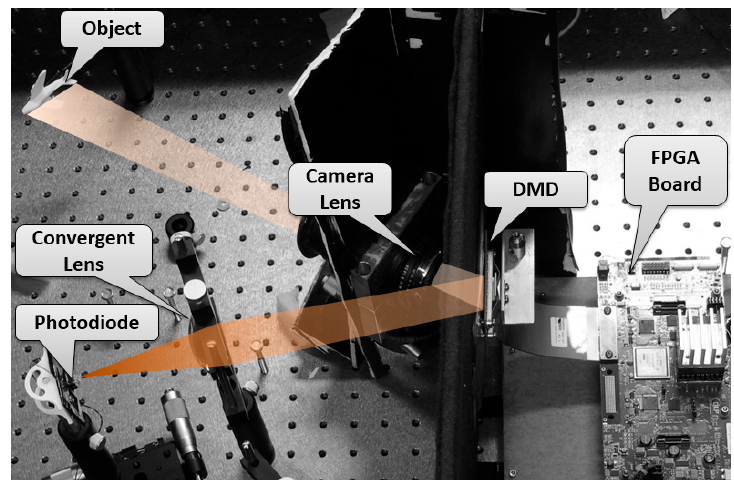
Figure 3. Experimental setup of the single pixel camera system.